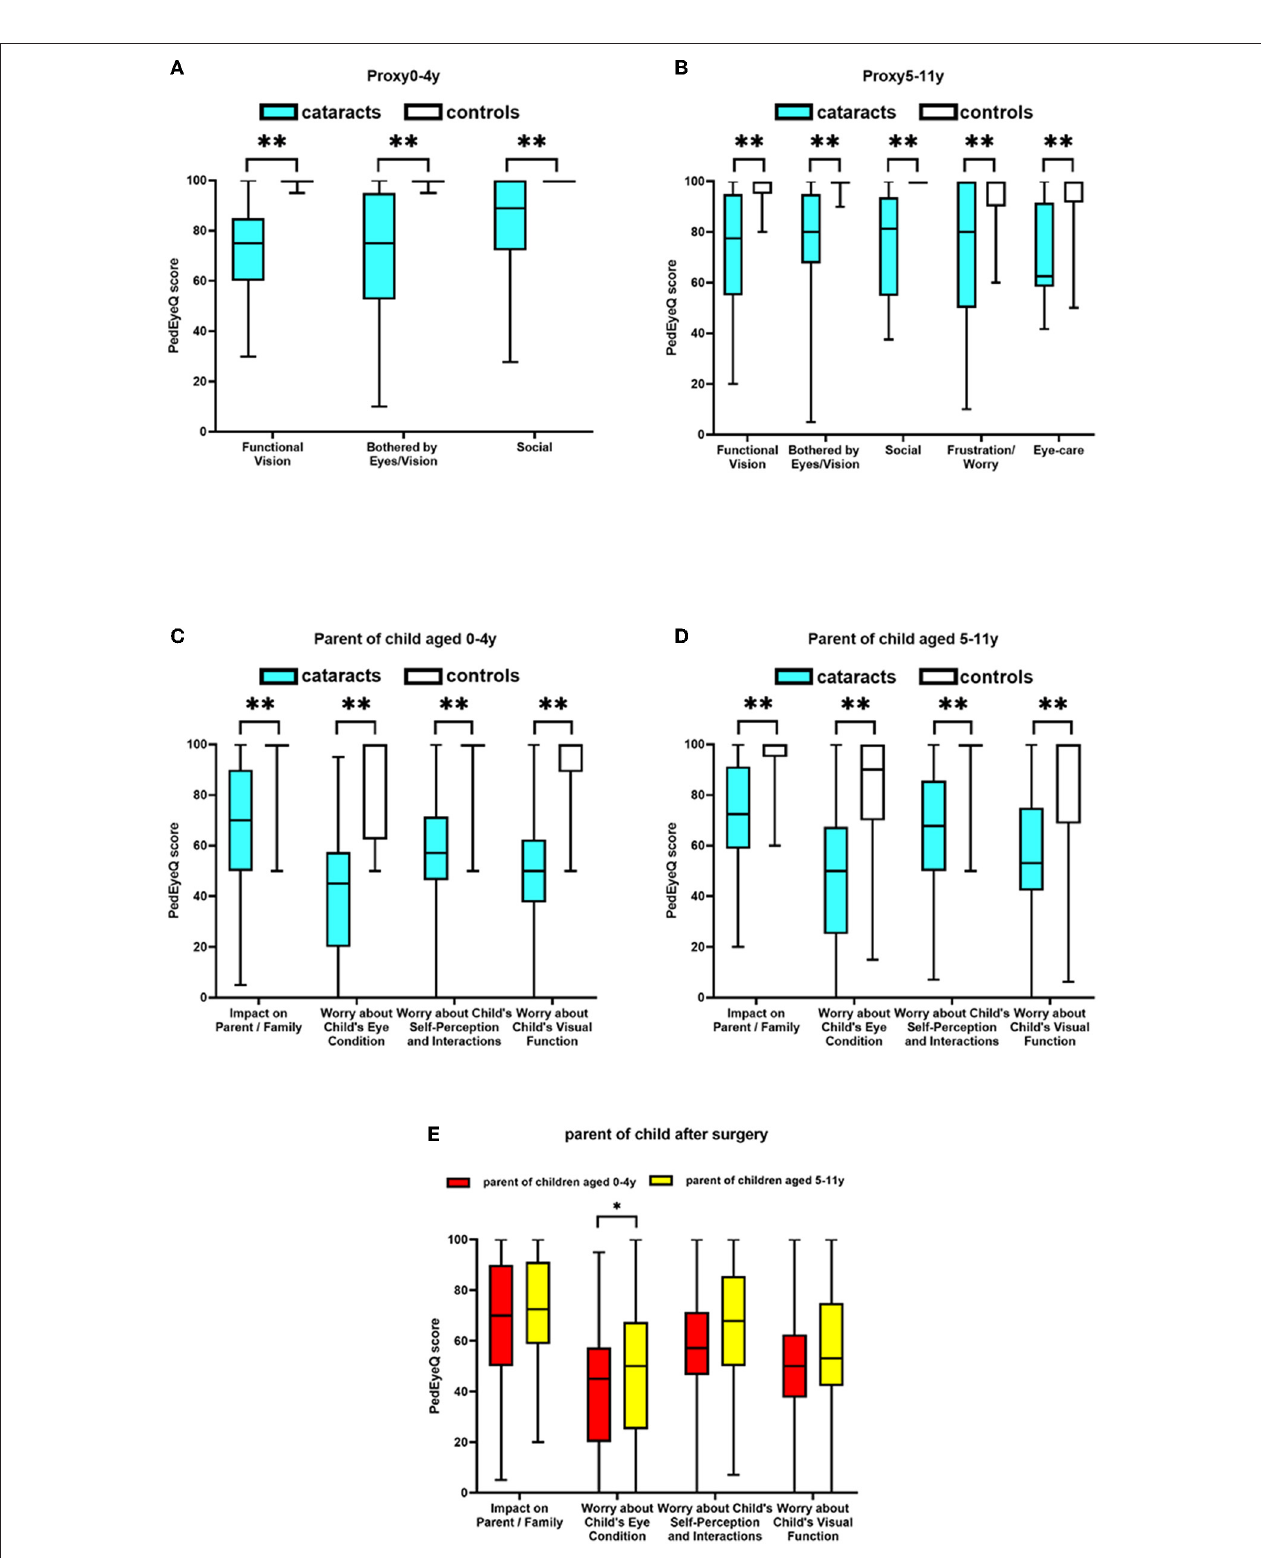
FIGURE 1 | PedEyeQ domain scores in children following congenital and developmental cataracts surgery compared to healthy controls; (A) Proxy PedEyeQ scores for children aged 0–4 years; (B) Proxy PedEyeQ scores for children aged 5–11 years; (C) PedEyeQ scores for parents of children aged 0–4 years; (D) PedEyeQ scores for parents of children aged 5–11 years. (E) Comparison of PedEyeQ scores for parents of children after surgery. * means the results between two groups have significant difference statistically and ** means a greater significant difference.